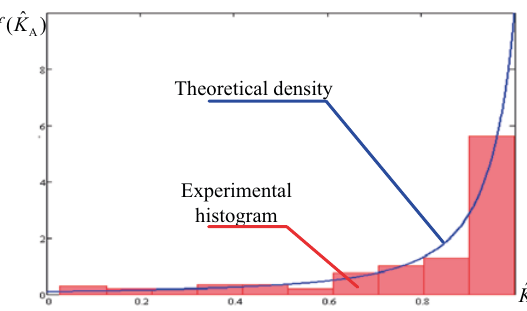
Fig. 7. PDF and histogram of the ready-to-operate factor estimation for the case